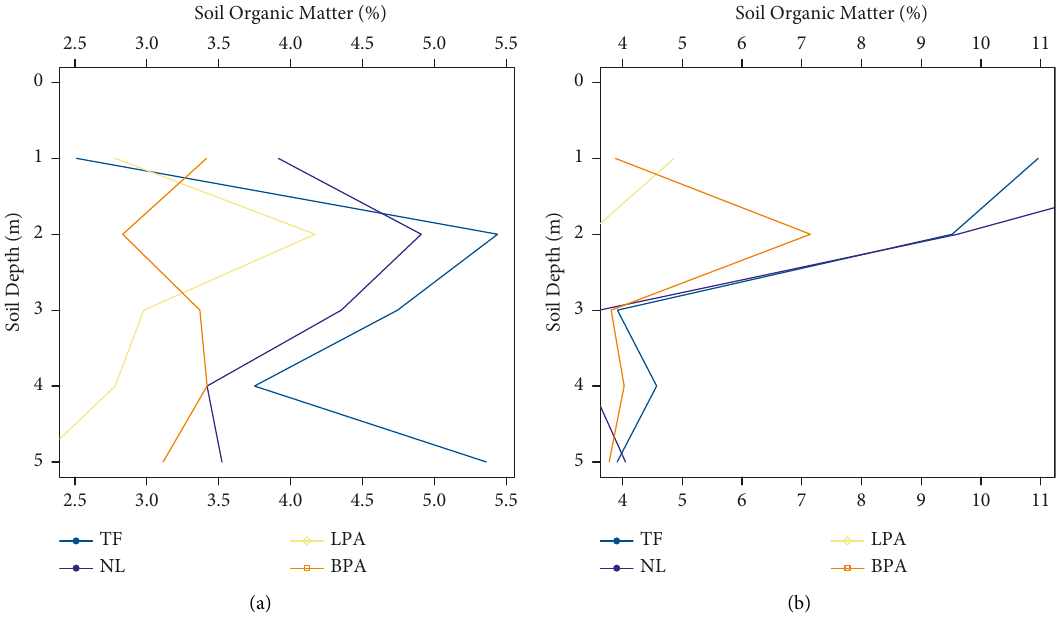
Figure 6: Soil organic matter (SOM) along soil profiles in the landform of Barito Delta. TL is tidal flat, NL is natural levee, LPA is limb of peat anticline, and BPA is basin of peat